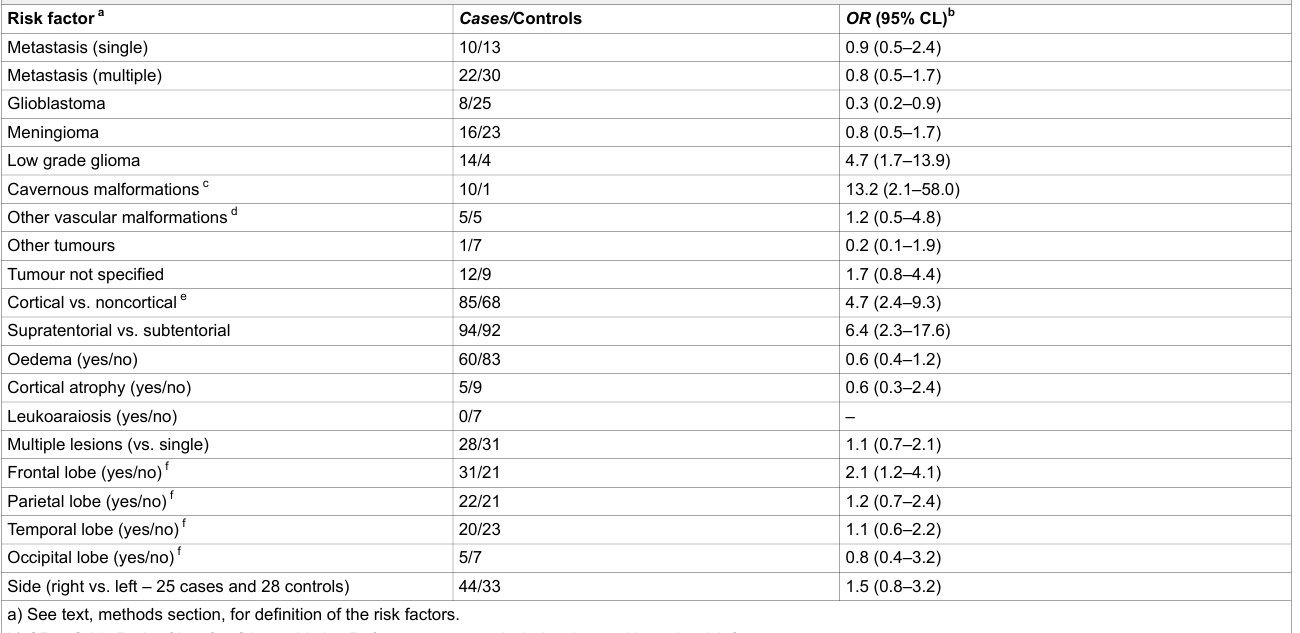
Table 2: Risk factors for a first seizure symptomatic of brain tumour or brain vascular malformation (98 cases and 117 controls with available imaging